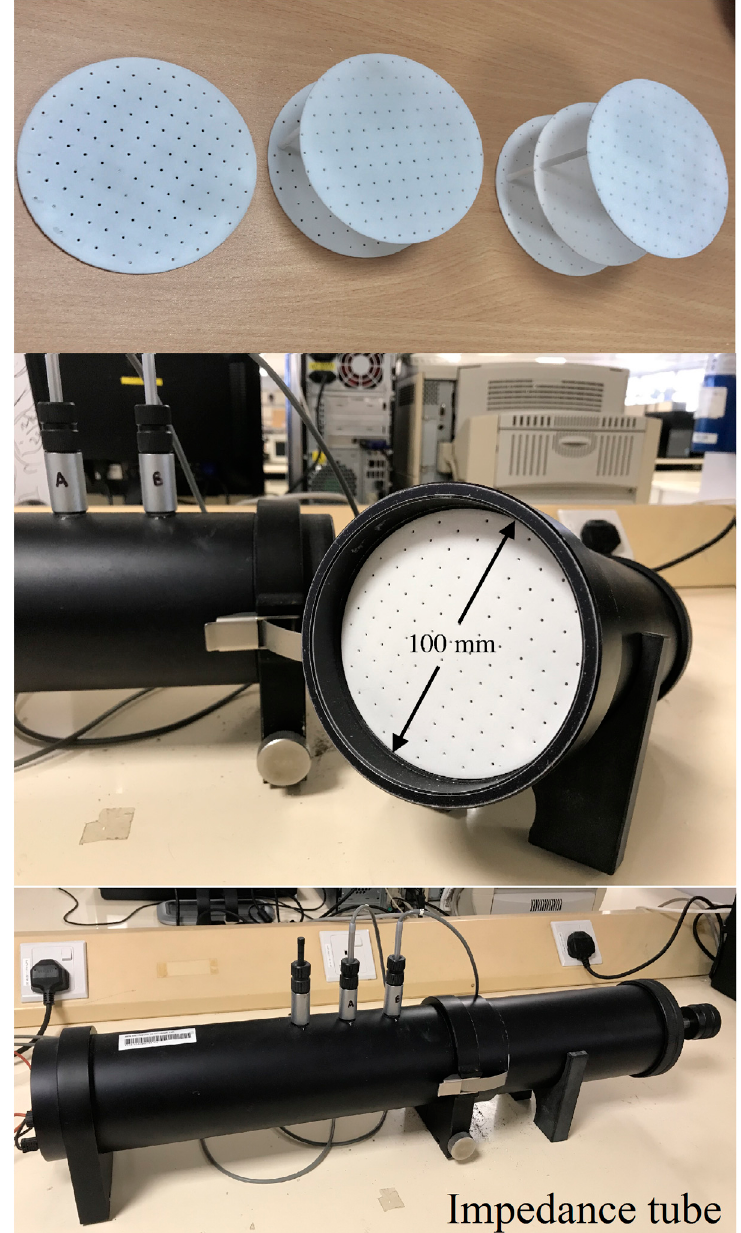
Figure 3. 3D printed samples of MPPs and the setup of the acoustic absorption test.